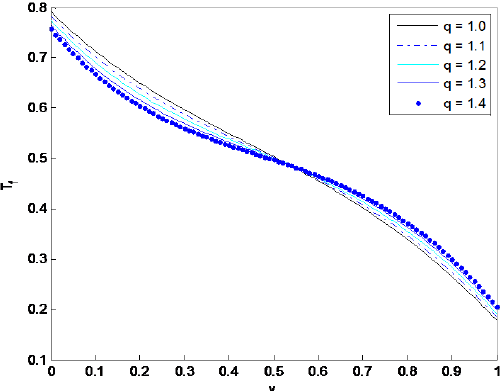
Figure 15: Temperature profile for different values of mass flux q ( Br = 0.2 , S = 0.4 , Gre = 10 , λ = −0.3 , ε = −0.3 , d = 0.2